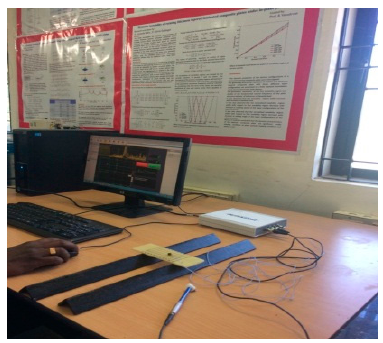
Figure 2. Experimental setup for the fundamental flexure frequency.